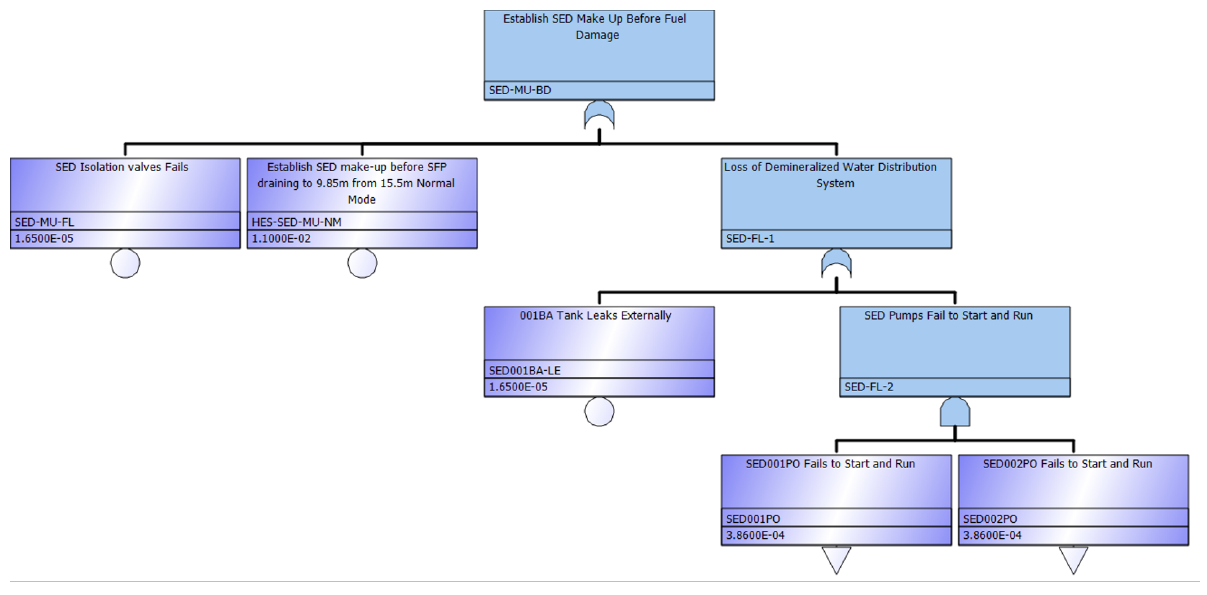
Figure 6. Failure Model of the SED System.